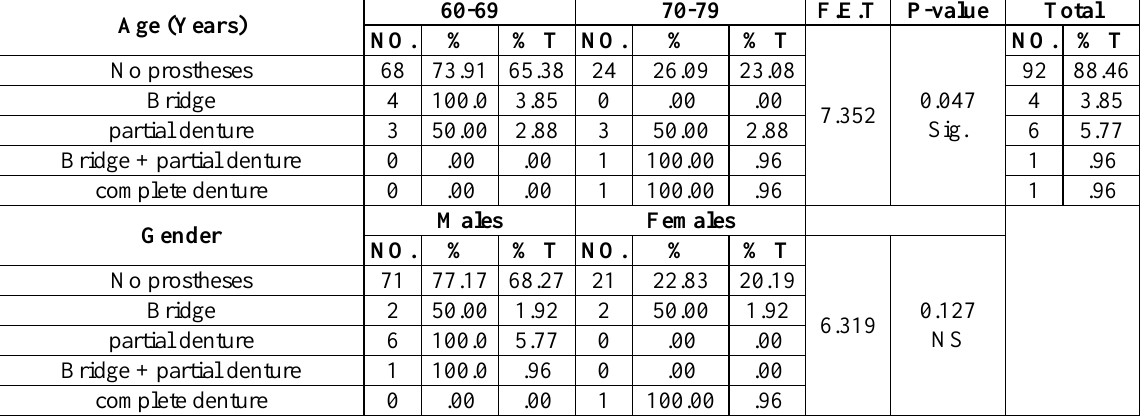
Table 3: Distribution of prosthetic status in lower arch by total and in age and gender.